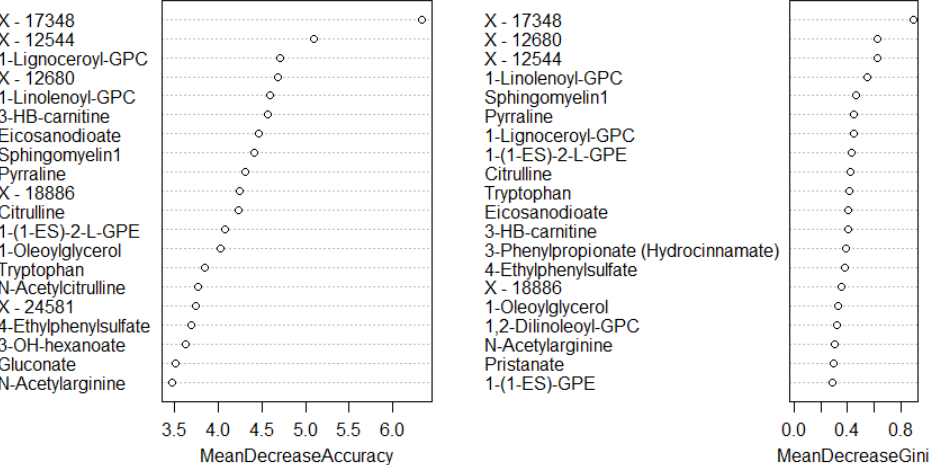
Figure 7. Top 20 discriminatory metabolites for the detection of early-stage endometrial cancer based on the training set ( n = 102, cancers = 47, controls = 55) identified by random forest machine learning technique and ranked by their contribution to classification accuracy using mean decrease accuracy and mean decrease gini index. Metabolites starting with X are unnamed; the pathways of these are